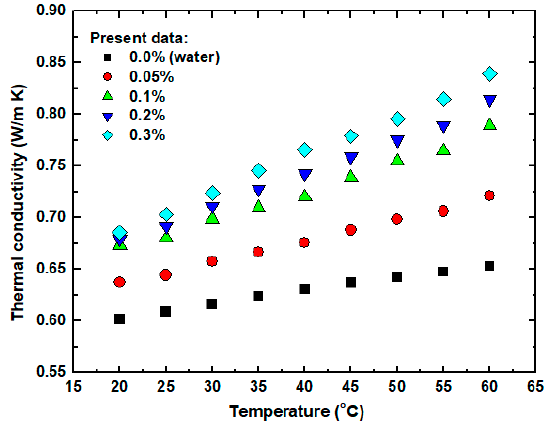
over the base fluid.